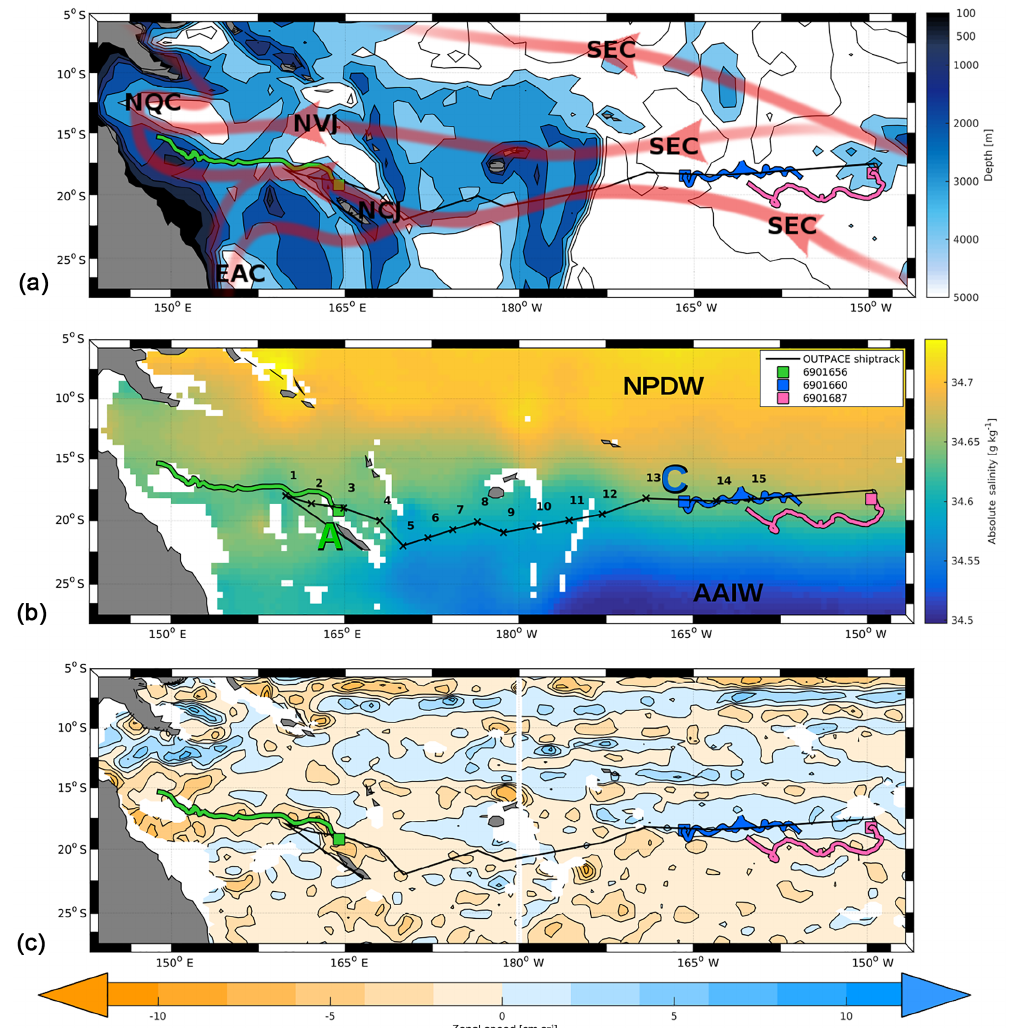
Figure 1. Western South Pacific Ocean (a) main trajectories of zonal jets superimposed on the bottom topography (in m), (b) absolute salinity (gkg − 1 ) at 1000m for November climatology from the ISAS13 atlas and (c) zonal mean current (in cms − 1 , positive for eastward velocity) deduced from the Argo float displacement at their parking depth (near 1000m, adapted from Ollitrault and Colin de Verdière, 2014). The colored lines represent the studied floats (WMO number in the inset) with squares for their immersion location. The currents shown in the upper panel are the South Equatorial Current (SEC), the North Vanuatu Jet (NVJ), the North Caledonia Jet (NCJ), the North Queensland Current (NQC) and the East Australia Current (EAC). The water masses shown on the middle panel are the North Pacific deep water (NPDW) and the Antarctic intermediate waters (AAIWs). The black line represents the ship track of the OUTPACE cruise; in the middle panel, the crosses represent the short-time stations (numbers), and the squares A and C represent two of the long-time stations of the cruise where the floats in this study were